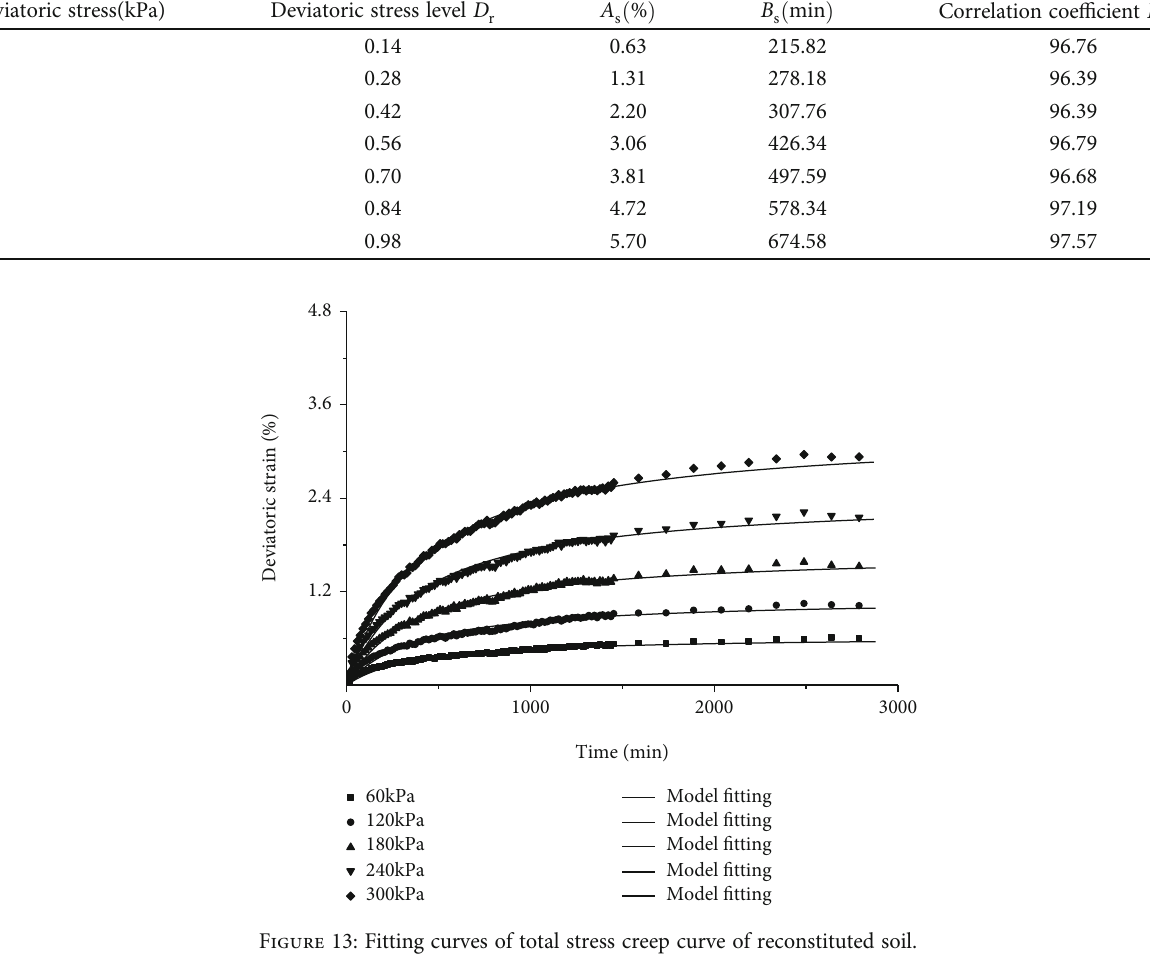
Table 5: Hyperbolic model parameters and correlation coe ffi cient R 2 of triaxial creep test (intact clay). Deviatoric stress(kPa)